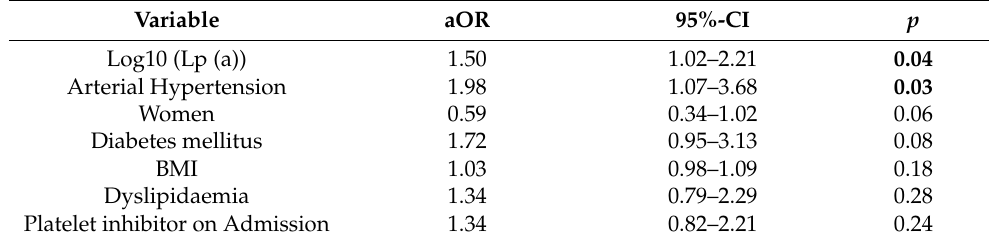
Table 3. Multivariable logistic regression model for the association with large artery atherosclerotic stroke and Lipoprotein